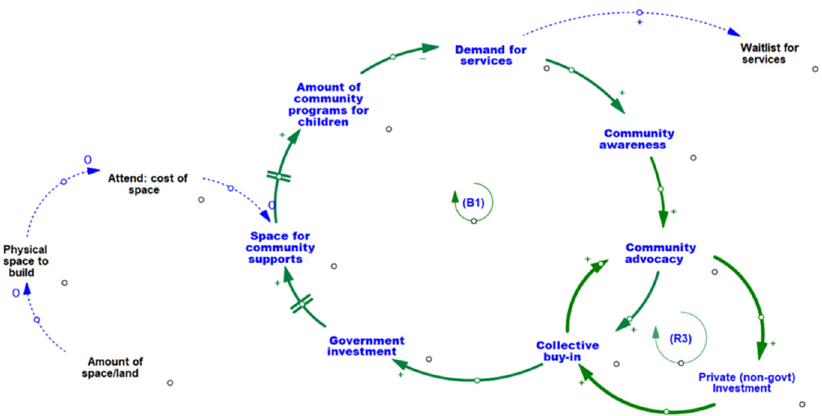
Figure 2. CLD of interrelationships between amount of community programming, levels of collec- community action, and availability of physical space and tive community action, and availability of physical space and infrastructure.